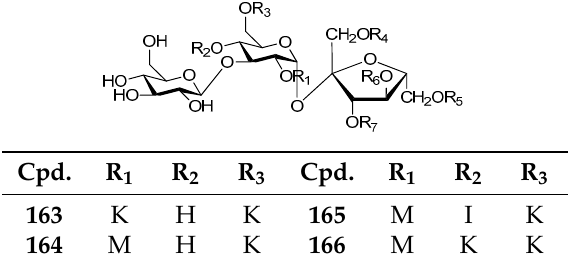
Figure 17. Structures of compounds 163 – 166 .